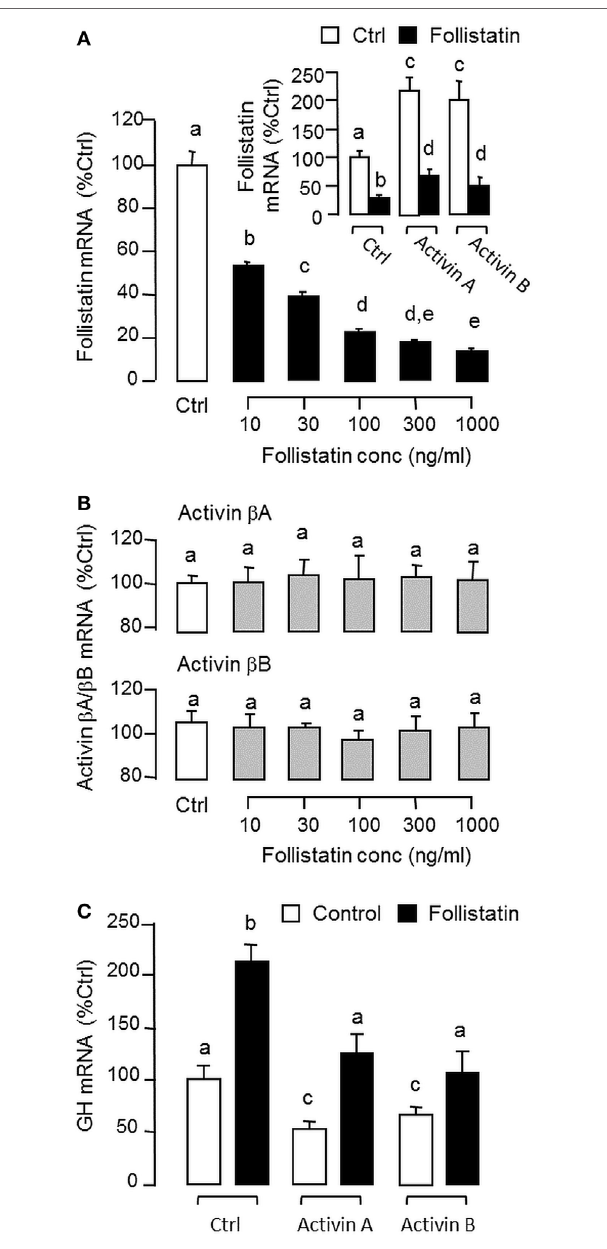
FigUre 4 | Removal of endogenous activin by follistatin on follistatin, activin β A, and activin β B expression in grass carp pituitary cells. (a) Effects of follistatin treatment on basal and activin-induced follistatin mRNA expression. (B) Effects of follistatin treatment on activin β A and β B mRNA expression. (c) Effects of follistatin treatment on basal and activin-induced growth hormone (GH) mRNA expression. To examine the effect on basal expression of follistatin mRNA, pituitary cells were treated for 24 h with increasing doses of follistatin as indicated. To test the effects of follistatin on activin modulation of follistatin and GH gene expression, pituitary cells were challenged for 24 h with activin A (10 ng/ml) or B (10 ng/ml) with/without the co-treatment of follistatin (100 ng/ml). In these experiments, total RNA was isolated after drug treatment and subjected to real-time PCR of follistatin, activin β A, activin β B, and GH mRNA, respectively. Data presented are pooled from four separate experiments ( N = 4) and the groups denoted by different letters represent a significant different at P <